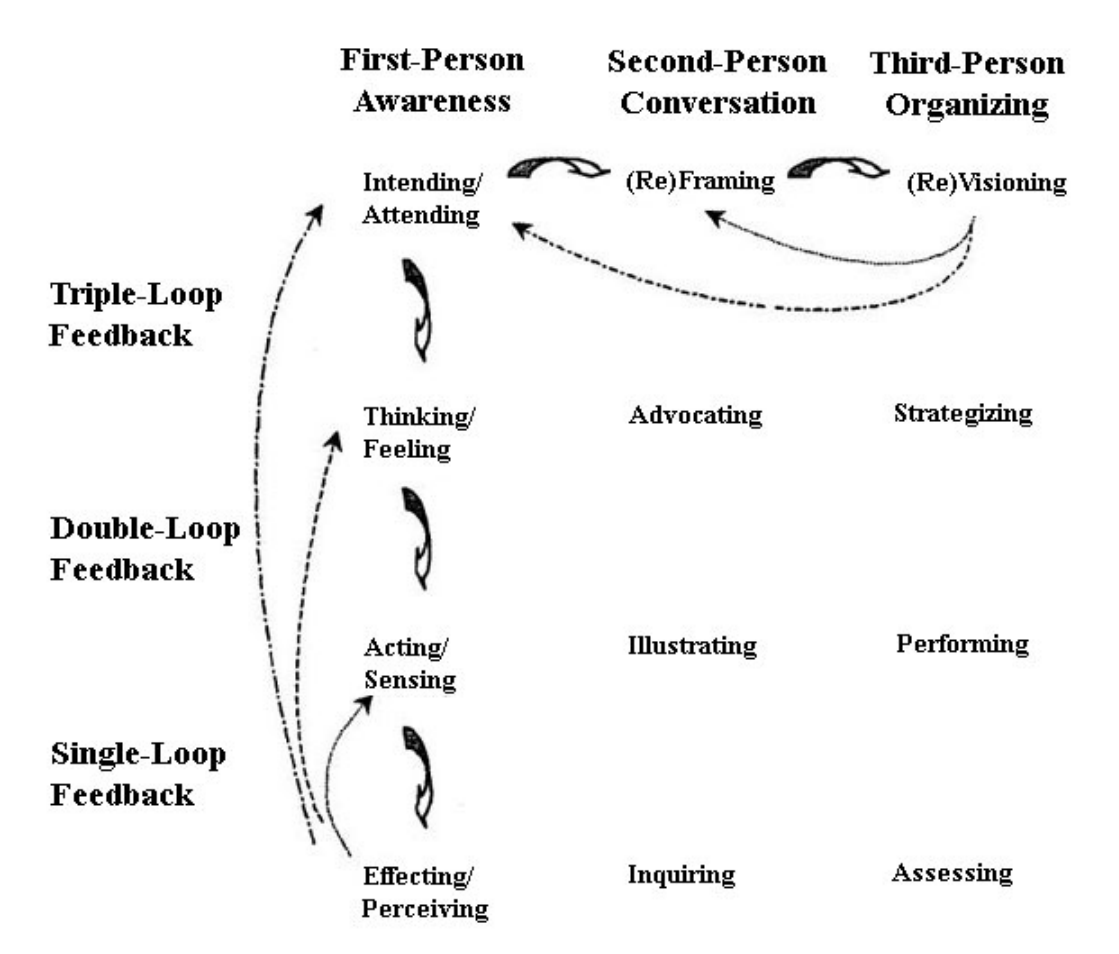
Fig. 2. The span of research/practice with four territories of experience (Chandler and Torbert